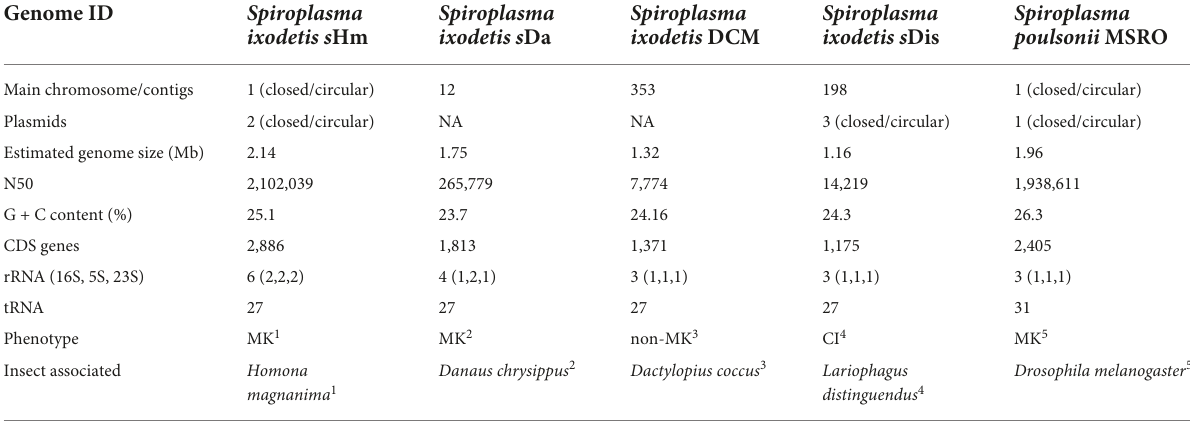
TABLE 2 Genomic features of strain s Hm and other Spiroplasma strains found in insects. Genome ID